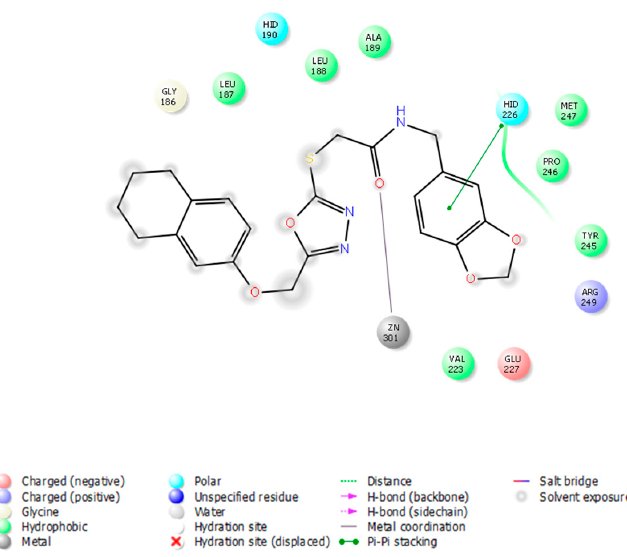
Figure 2. Docking position and interactions of compound 8 at the active site of MMP-9 (PDB code: 5I12), respectively. (Ligand custom carbons are colored in pink for compound 8 and the zinc atom is displayed in grey sphere).